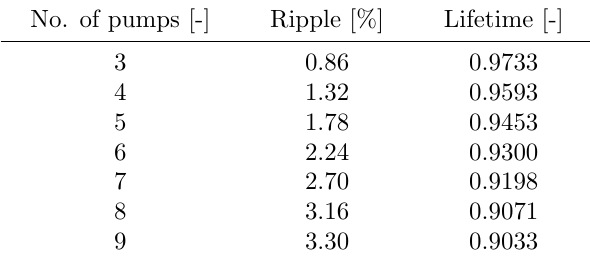
Table 15: Effect of number of pumps in use on